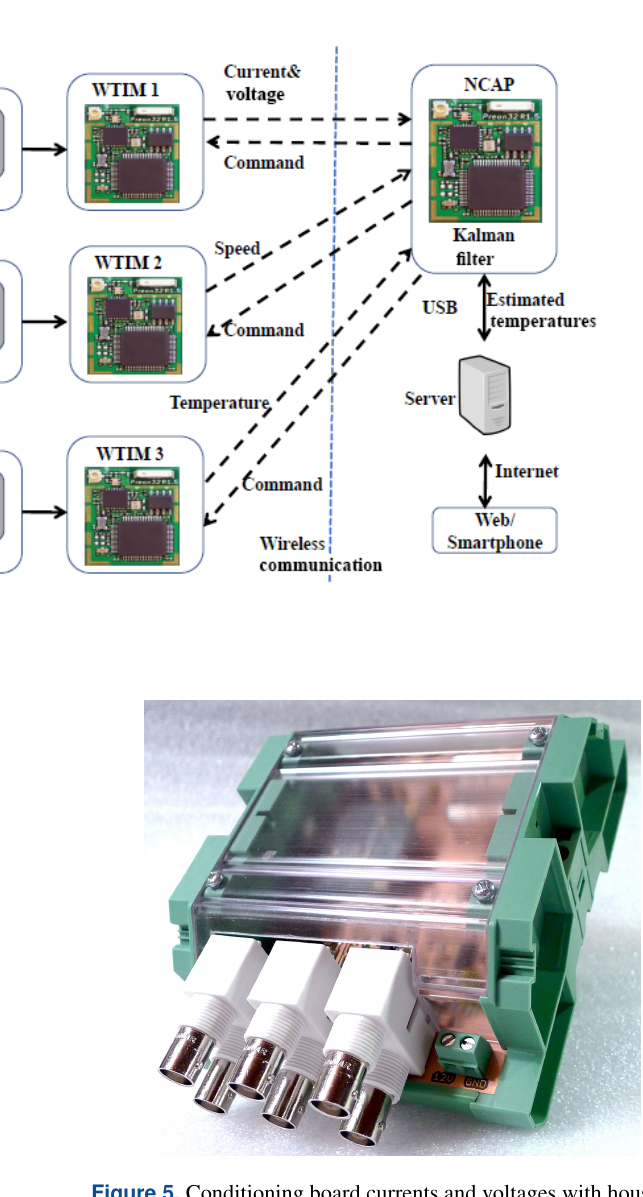
Figure 5. Conditioning board currents and voltages with